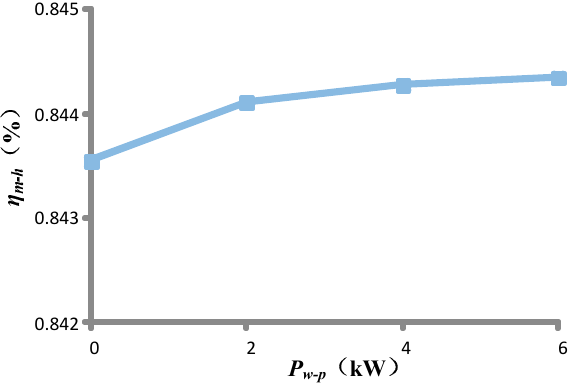
Figure16. The influence of parameter P w-p on the efficiency of the mechanical-hydraulic